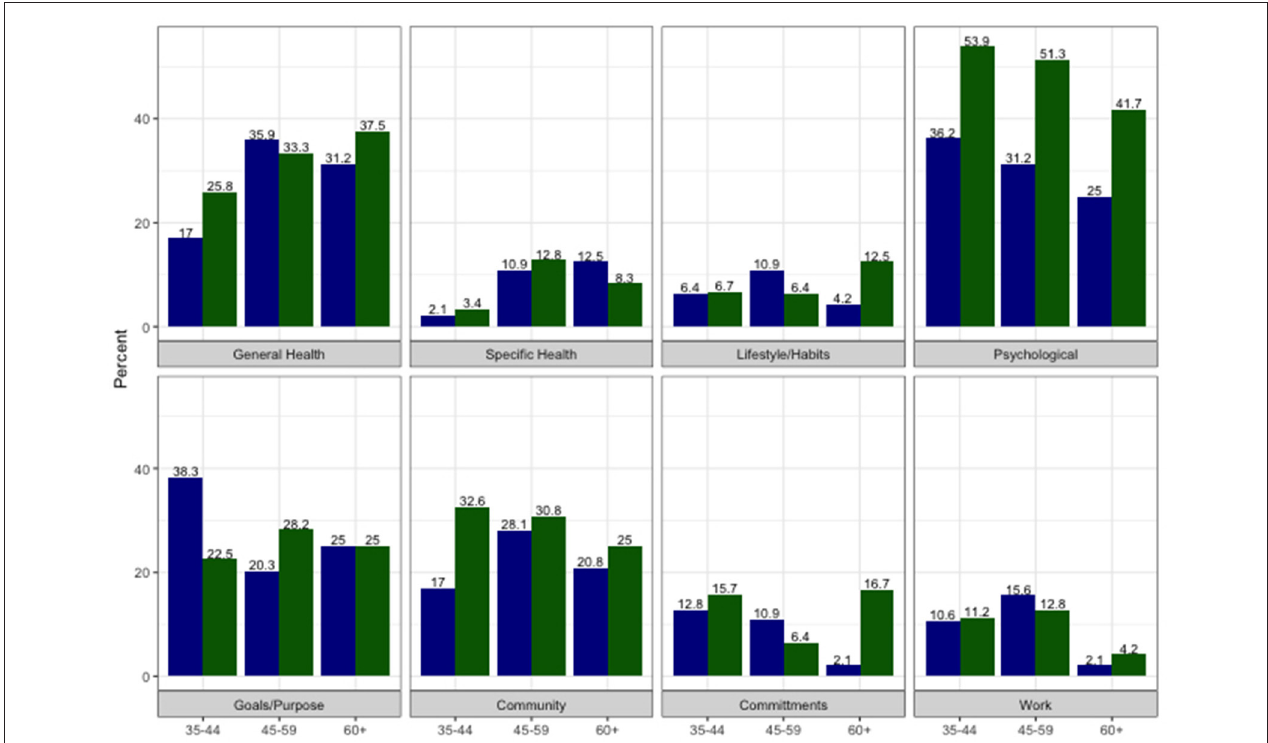
FIGURE 1 | Percent of comments coded in different content categories by gender and age groups (blue for men and green for women).